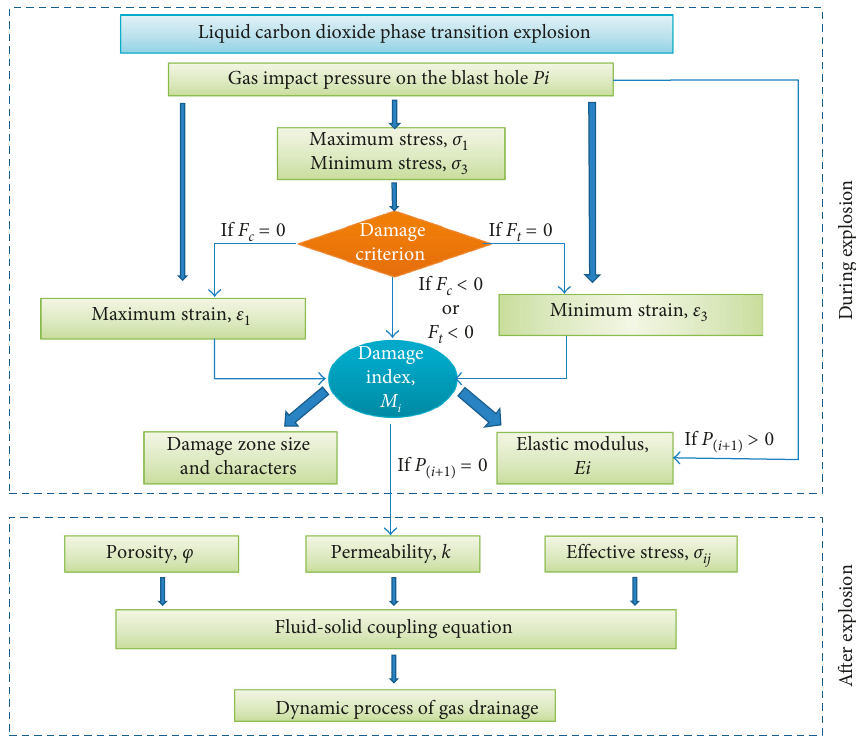
Figure 6: Process of numerical calculation.